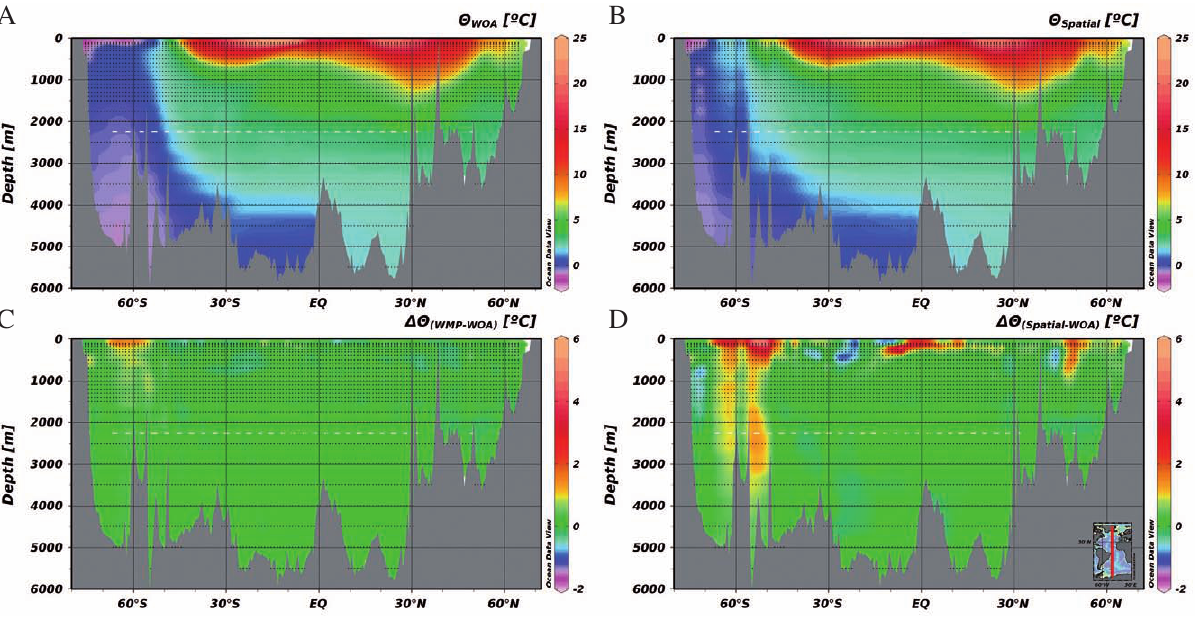
Fig . 2. – Potential temperature (ºC) variability along 28ºW from the WOA05 dataset (A), spatially interpolated from CARINA data (B). Residuals of WMP interpolated (C) and spatially interpolated (D) potential temperature both as interpolated minus WOA05.